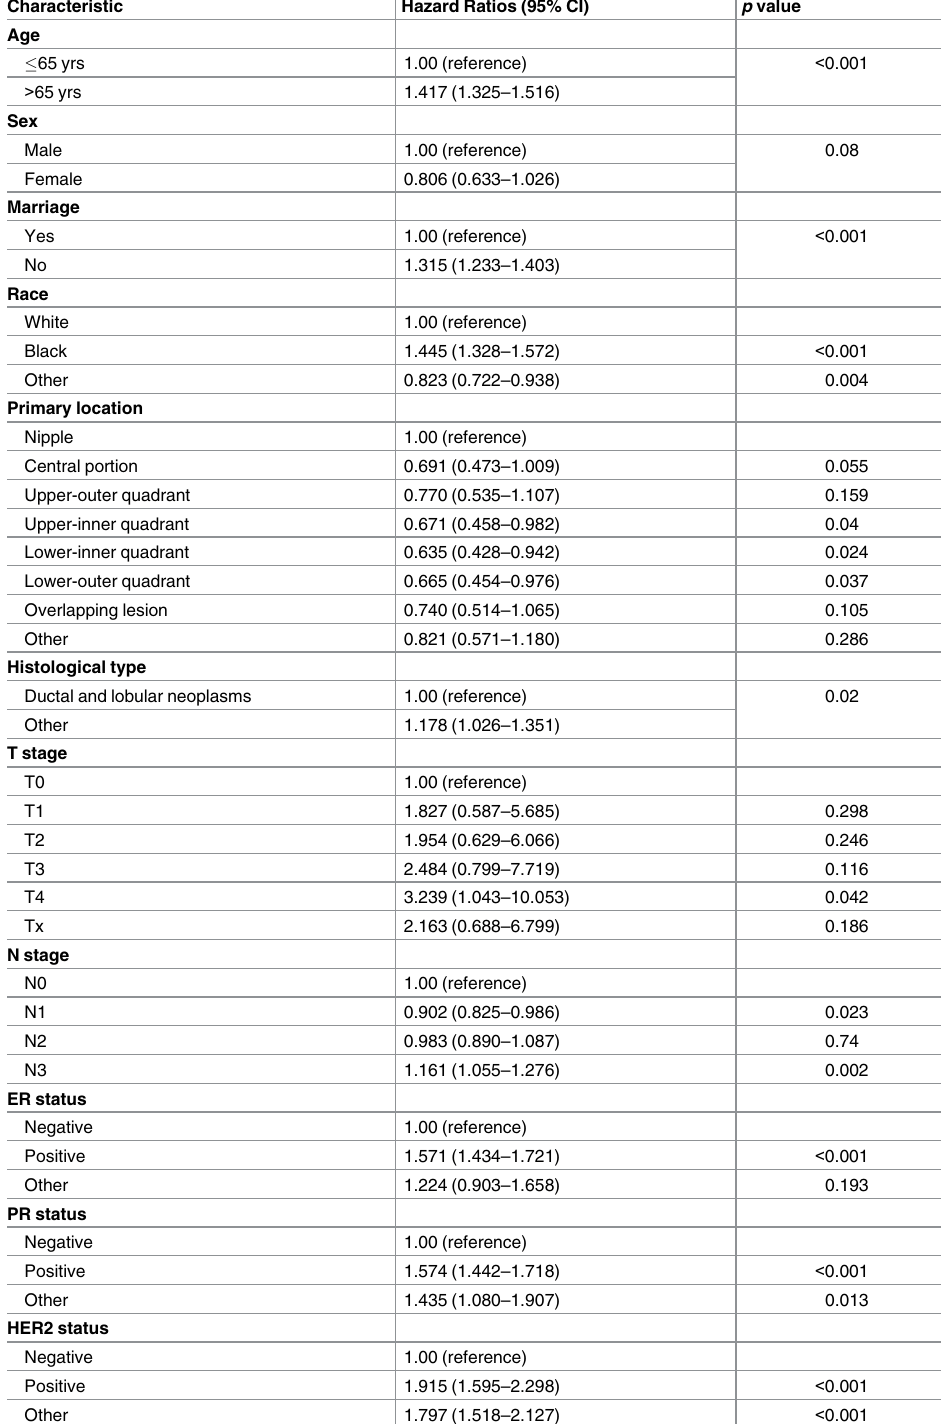
Table 2. Cox proportional hazards regression model for breast cancer–specific survival in patients with M1